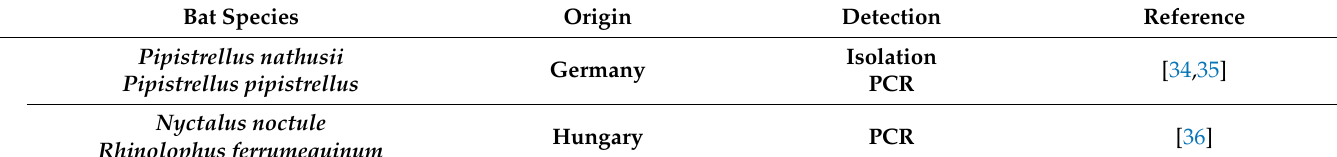
Table 2. Overview on viruses detected in European bats with references (Data from DBatVir